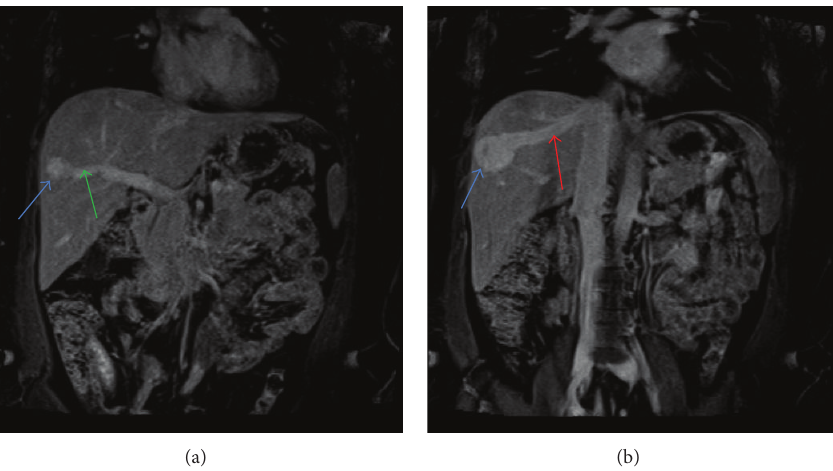
Figure 4: A 45-year-old female with intrahepatic portosystemic venous shunt with associated aneurysms. (a) Contrast enhanced coronal VIBE MRI showing communication between the right anterior portal vein branch (green arrow) and right hepatic vein through 28 mm aneurysm (blue arrow). (b) Coronal VIBE MRI (a few sections posterior to (a)) demonstrating communication between the right portal vein and right hepatic vein (red arrow) through a second, larger, 37 mm aneurysm (blue arrow). Protocol: Siemens, 1.5 Tesla Avanto MR Scanner, TR = 4.3, TE = 1.91, 3.5 mm slice thickness, Matrix = 256 × 256, with 15 mL Gadobenate dimeglumine (Multihance, Bracco Diagnostics Inc.)